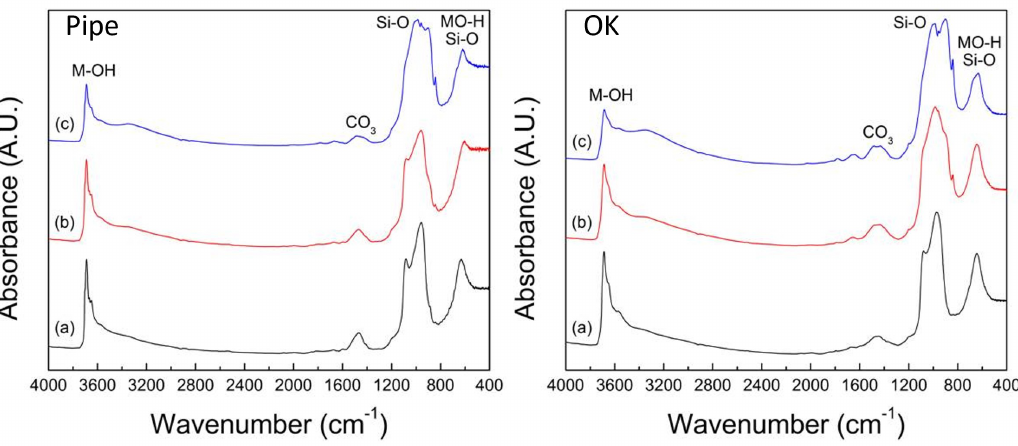
Figure 6. FTIR spectra obtained for Pipe ore (untreated ( a ) and microwave pretreated for 4 ( b ) and 8 ( c ) min) and OK ore (untreated ( a ) and microwave pretreated for 8 ( b ) and 15 ( c ) min).